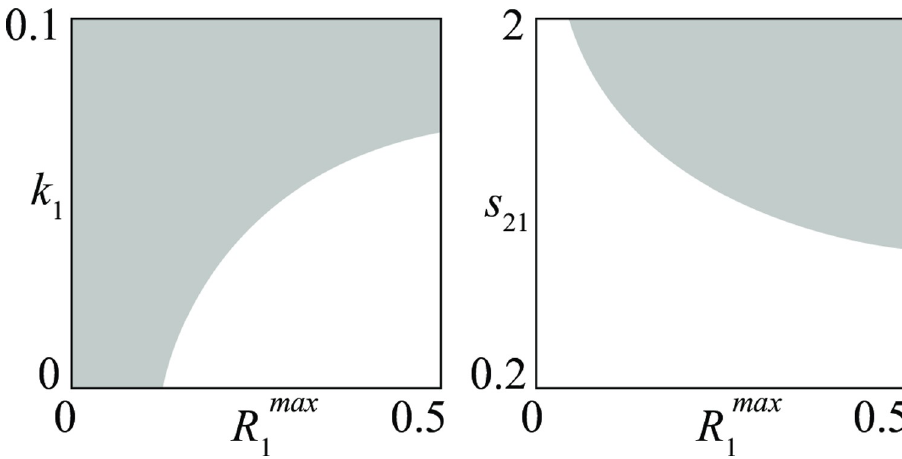
Fig 5. Sets of D—D conflicts (shaded regions) where the victory of the first group is guaranteed. (a) the brute force principle holds; (b) the brute force principle holds only if the second group has a heavy bureaucratic burden s 21 .